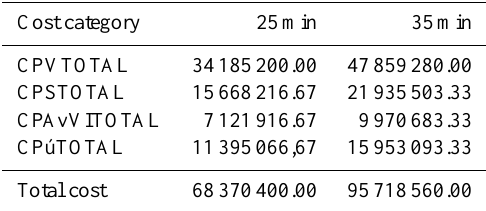
Table 4. Cost category expressed in delay of 25 and 35min.